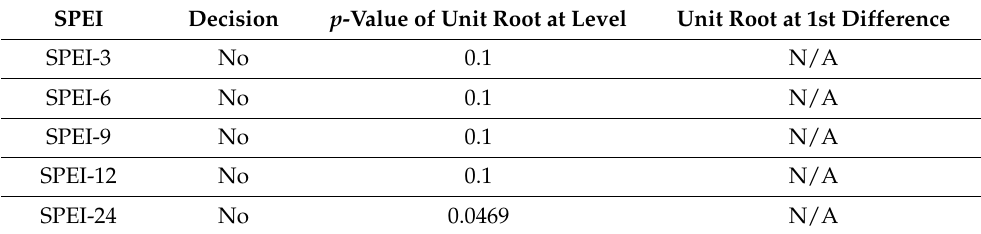
Table 5. KPSS test for level